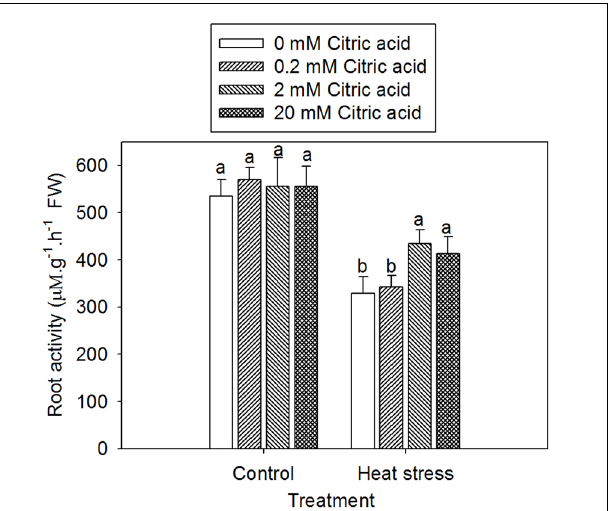
FIGURE 5 | Effect of exogenous citric acid on root activity under control (25/20 ± 0.5 ◦ C, day/night) and heat stressed (35/30 ± 0.5 ◦ C, day/night) conditions in tall fescue. Vertical bars on the top provide the standard deviation ( n = 4), and bars with the same letter indicate no significant difference at P < 0.05 for the comparison of different citric acid concentrations under control or heat